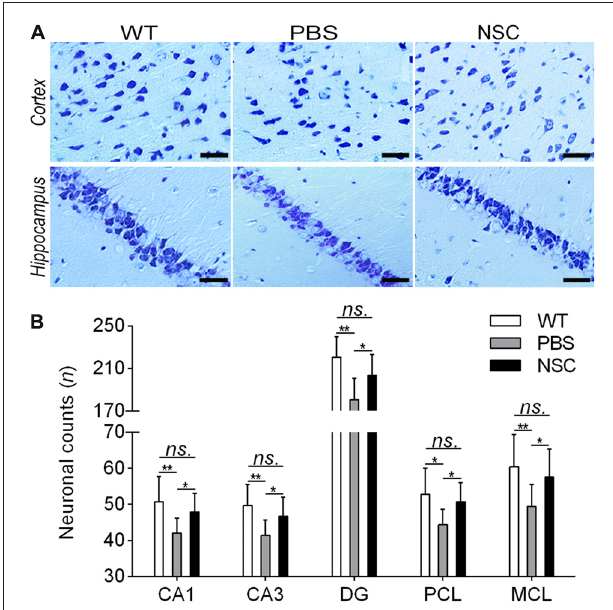
FIGURE 4 | hNSCs rescued neuronal loss in APP/PS1 mice. (A) Nissl-staining images in the frontal cortex and hippocampus of PBS, NSC group and WT mice. Scale bar: 20 µ m. (B) Comparisons of neuronal counts per view (40 × ) in the hippocampal CA1, CA3, DG regions and cortical pyramidal cellular layer (PCL) and multiform cellular layers (MCL) areas among three groups of mice. There was no significant difference in neuronal counts between the NSC group and WT mice ( ns. = p > 0.05), ∗ p < 0.05; ∗∗ p < 0.01 vs. the PBS